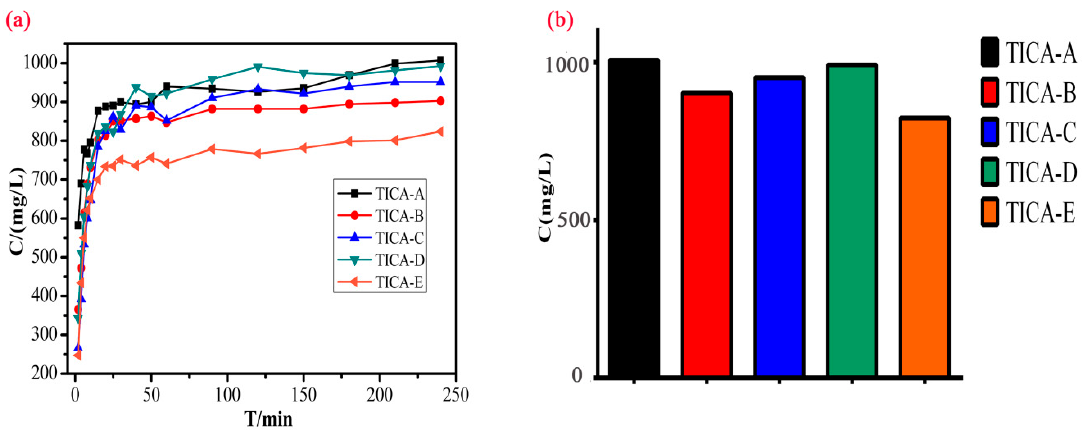
Figure 9. ( a ) Solution concentration–time profiles of TICA crystal habits in pH 1.2 hydrochloric acid solutions and ( b ) Amounts dissolved of TICA crystal habits in pH 1.2 hydrochloric acid solutions within 24 h.